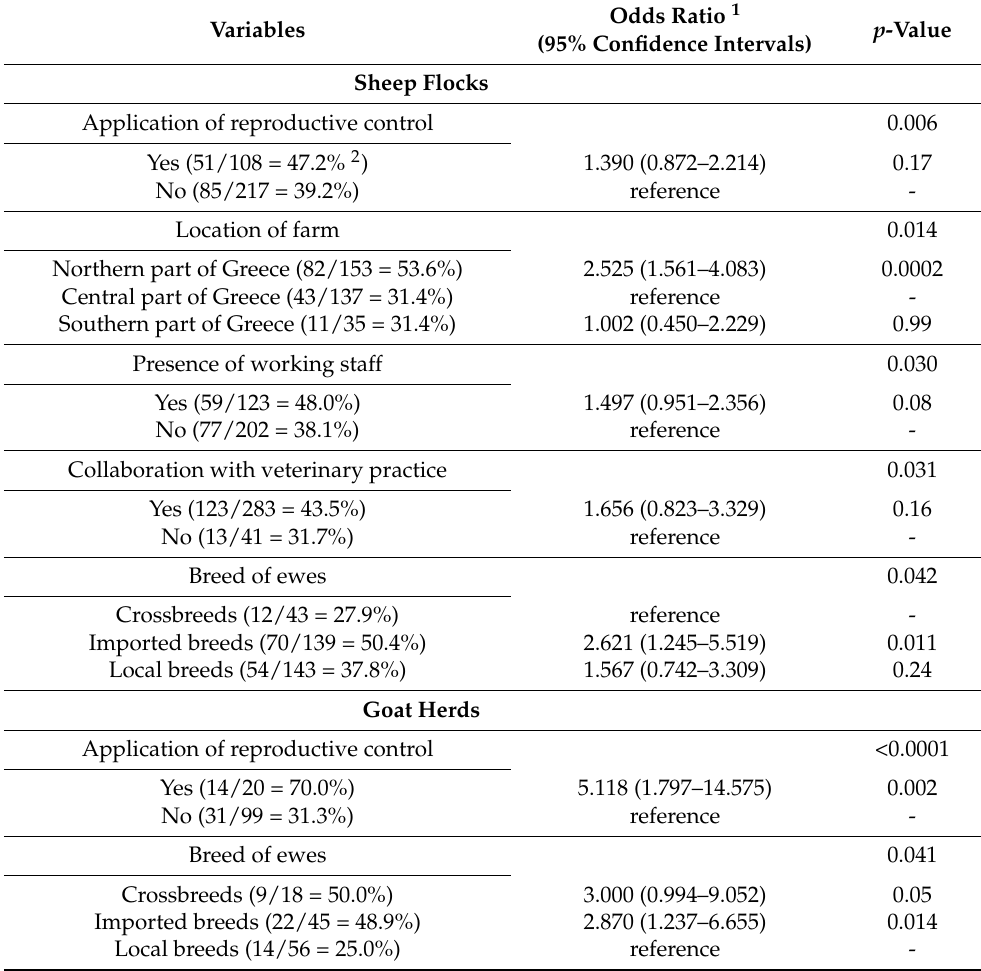
Table 3. Multivariable analysis for predictors for high number of lambs/kids born per ewe/female goat in sheep and goat farms in Greece.